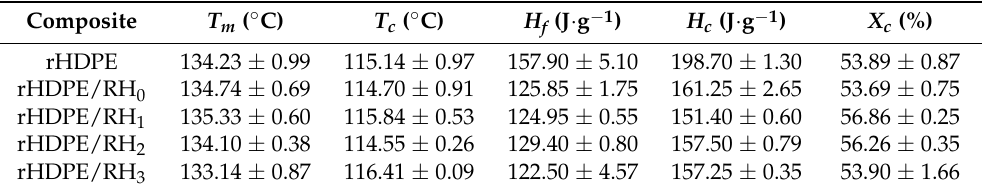
Table 4. Thermal properties of rHDPE and reinforced composites.